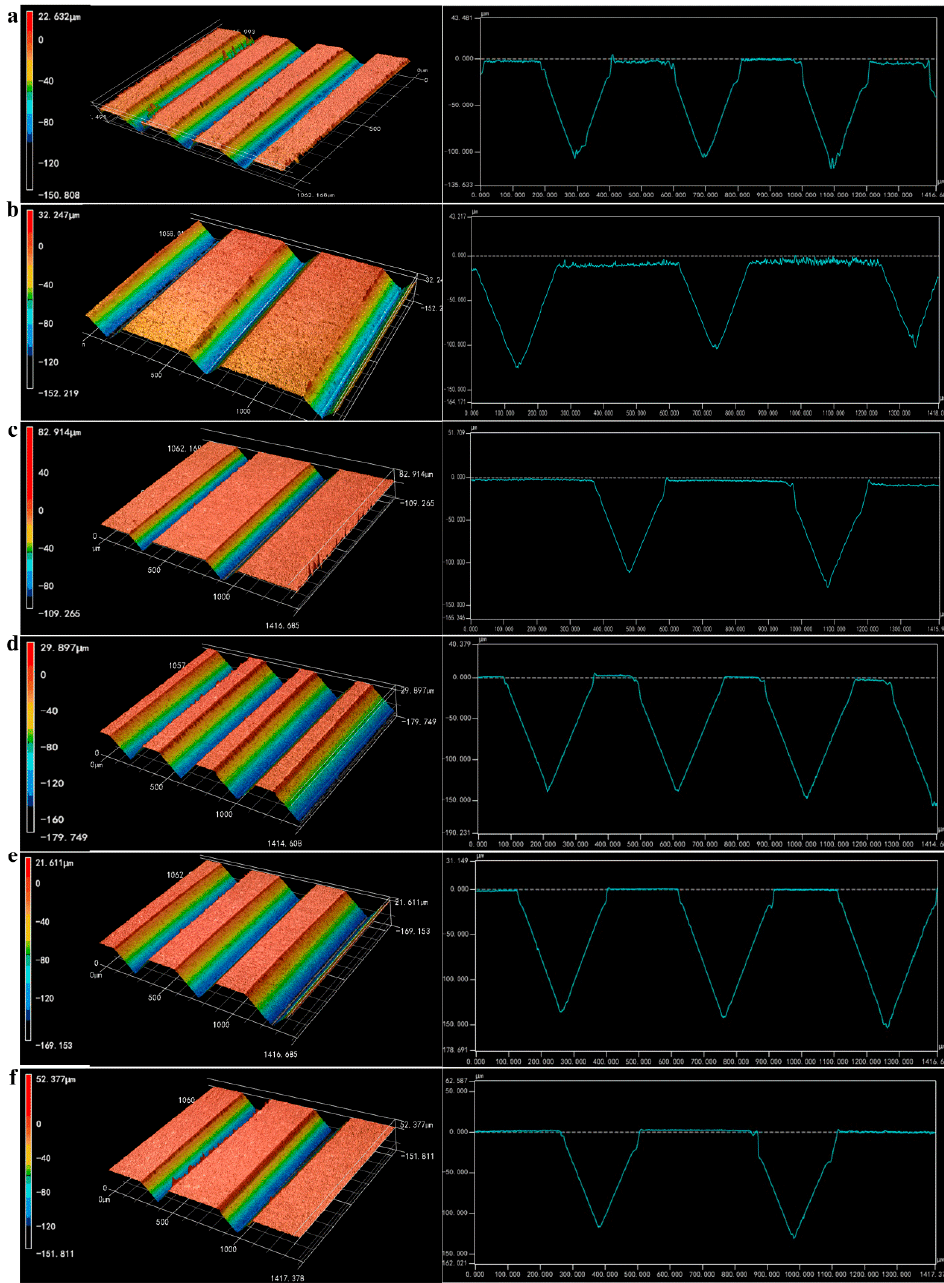
Figure 5. 3D topographies and profiles of micro-ground mold cores: (a) Sample A m ; (b) Sample B m ; (c) Sample C m ; (d) Sample D m ; (e) Sample E m ; (f) Sample F m .